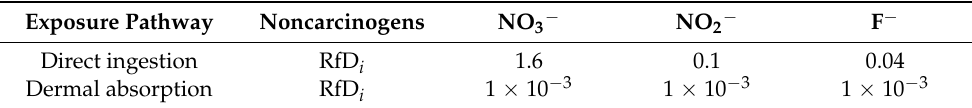
Table 3. Reference dose of noncarcinogens RfD i (mg/kg · d − 1 ) and carcinogenic intensity coefficients of chemical carcinogens q i (mg/kg · d − 1